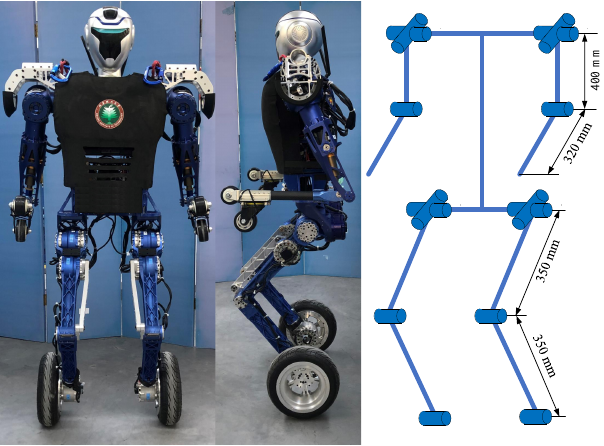
Figure 1. The wheel-legged robot BHR-W.